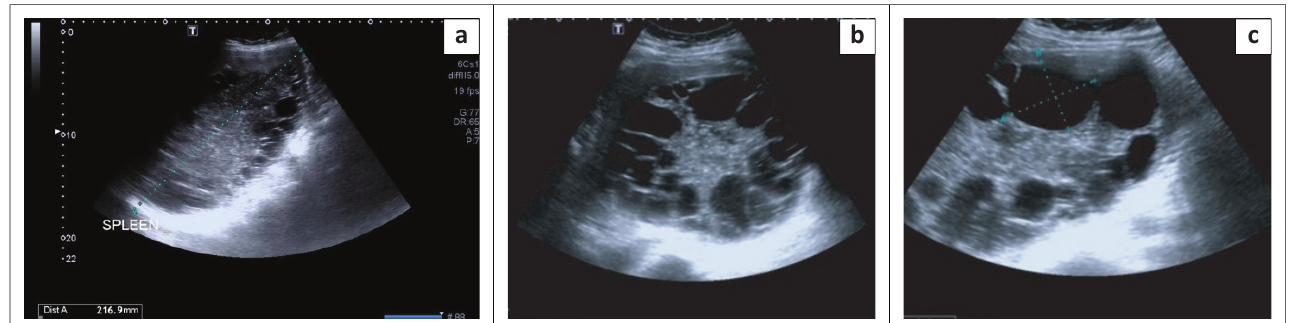
FIGURE 1: Images taken from the initial ultrasound done on presentation; (a) An image showing the enlarged spleen measuring 21 cm; (b) This image shows the extensive splenic hydatid cysts involving more than 90 % of the normal splenic tissue; (c) An indication of the largest splenic cyst measuring 4.8 cm × 4.0 cm.